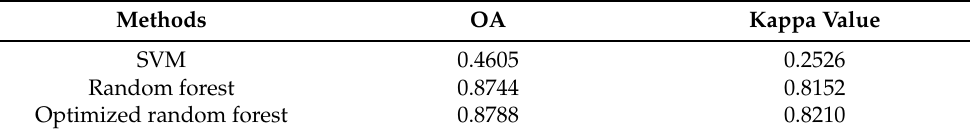
Table 3. A comparison between different methods using OA and kappa value (RGB features).